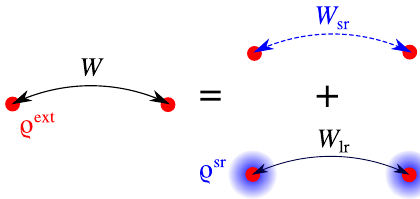
FIG. 1. Decomposition of the screened Coulomb interaction according to Eq. (9). The full interaction ( W ) between bare external charges ( ρ ext ) is split into their mutual short-range interaction ( W ) plus the long-range interaction ( W sr dressed charges ( ρ sr